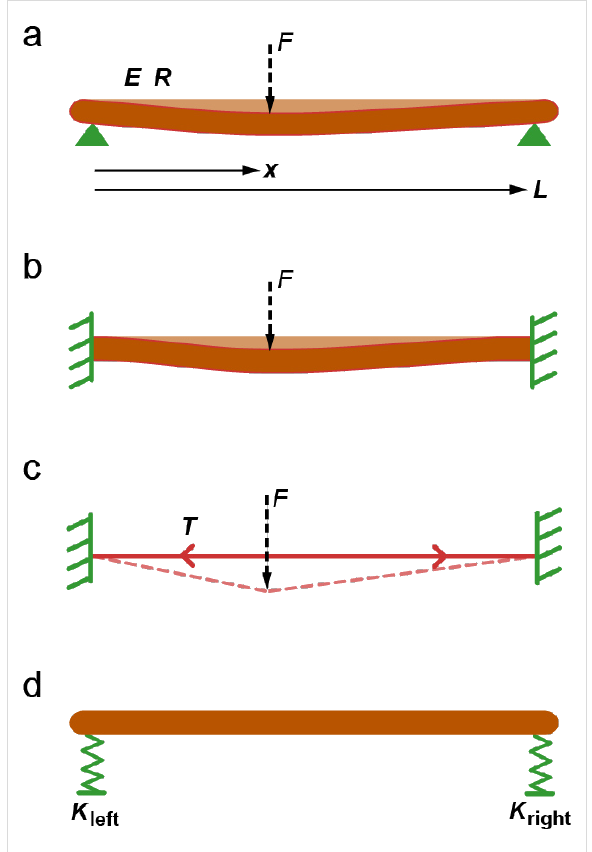
Figure 3: Illustration of possible mechanisms determining the local spring constant of suspended silk fibers. (a) “Pinned-end model” assumes that the fiber displacement is zero at the nodes; however, there is no constraint on its angle at the nodes. E elastic modulus, R is fiber radius, L is branch length. (b) “Clamped-end model” assumes that both the angle and displacement at the nodes are zero. (c) “Tension model” assumes the fiber has a built in tension T and negligible bending modulus. (d) “Suspended rigid rod model” assumes the nodes have finite spring constants K left and K right . Note that the spring constant according to the mechanism in (d) acts in series with the mechanisms in